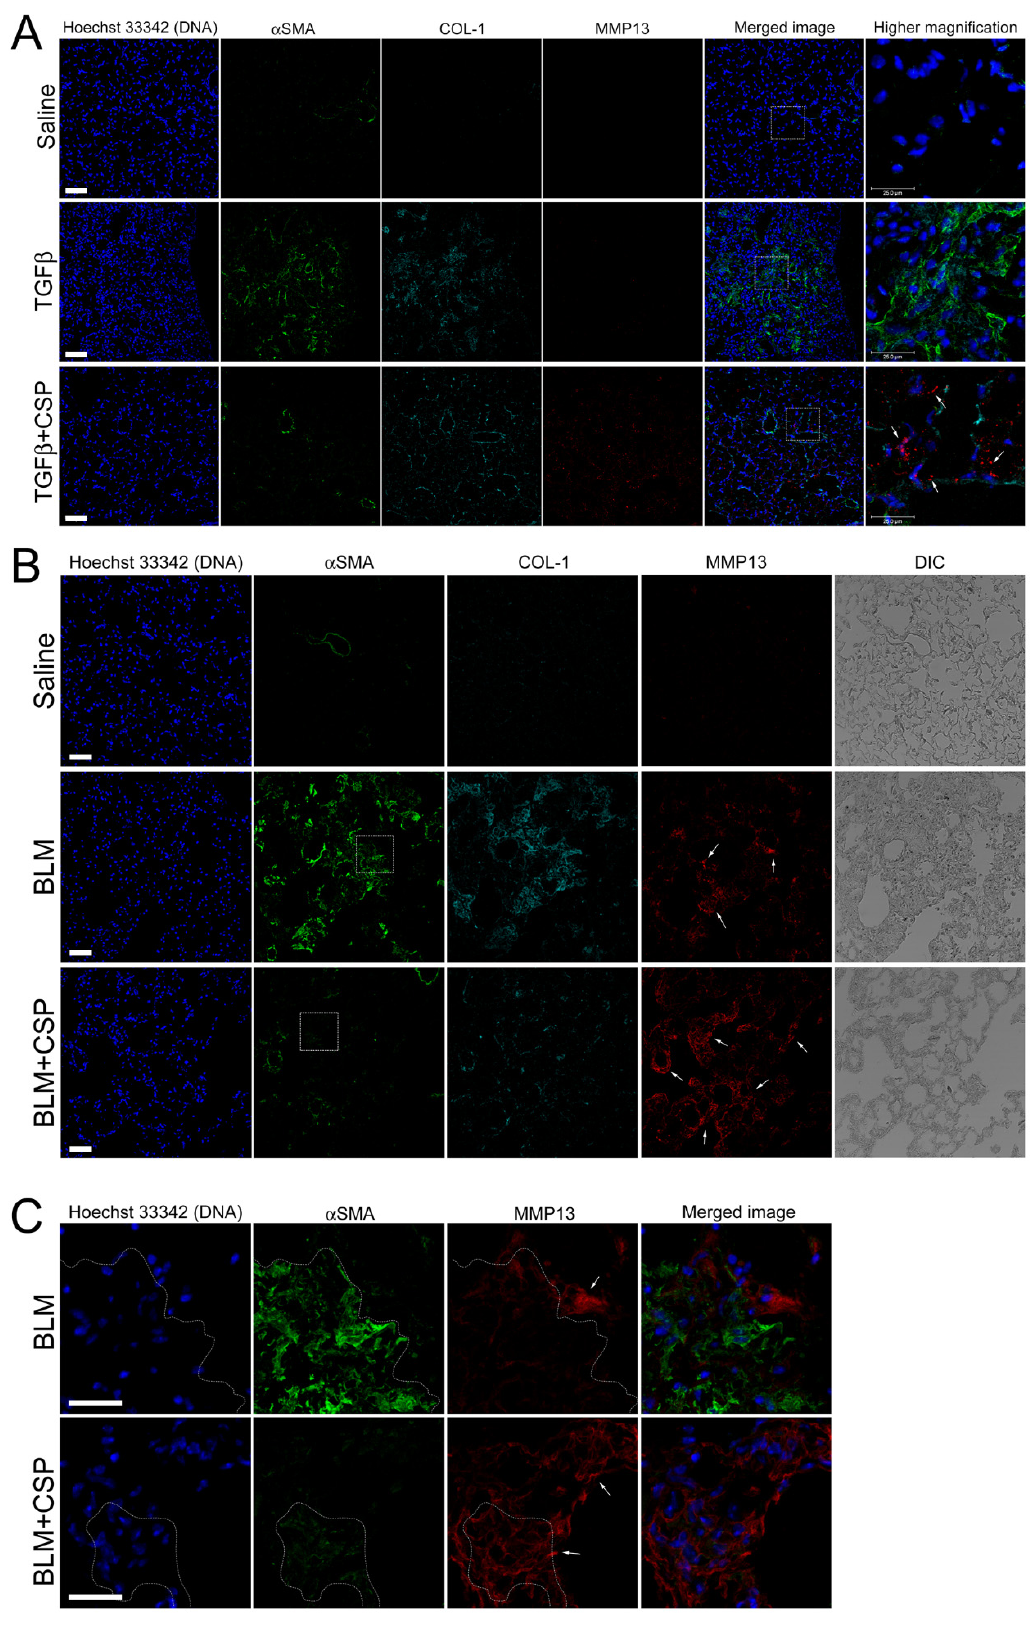
Figure 7. CSP promoted MMP13 expression in murine models of lung fibrosis: ( A ) Effect of CSP on TGF β -induced established PF. Lung sections from mice exposed to Saline, Ad-TGF β , and Ad-TGF β +CSP were stained with DNA (blue), MMP13 (red), collagen-1 (cyan), and α SMA (fibrotic